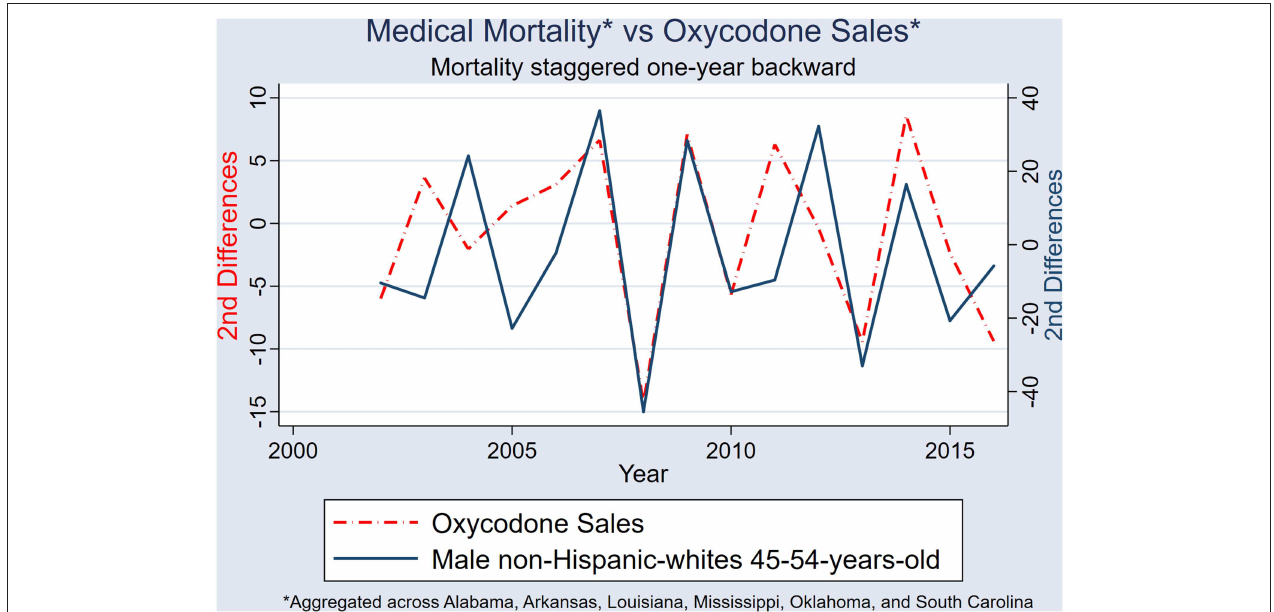
FIGURE 10 | Second differences of state-aggregated, annual oxycodone sales, and male NHW45-54 medical-cause mortality, using a backward adjustment of time series by 1